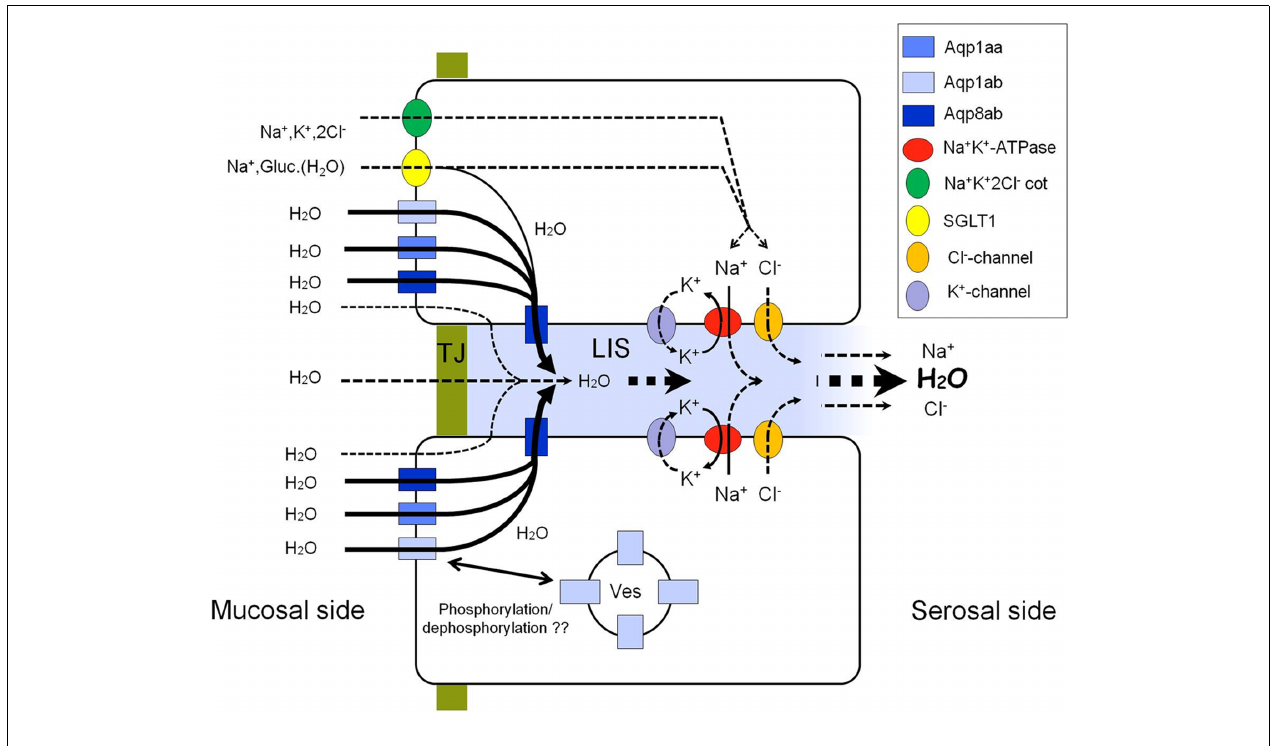
FIGURE 12 |Tentative model of the pathways of water absorption across the intestinal epithelium in salmonids. An osmotic gradient is set up across the lateral membrane by means of the Na + , K + -ATPase.Water may be drawn osmotically through four pathways: (1) diffusion through the lipid bilayer of the enterocyte; (2) paracellular diffusion through theTJ; (3) symport with Na + and glucose by the SGLT1; (4) diffusion through